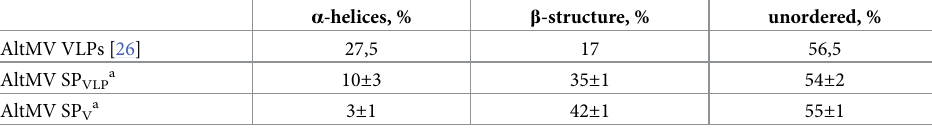
a Data for SP VLP and SP V are expressed as the mean ± SEM of two